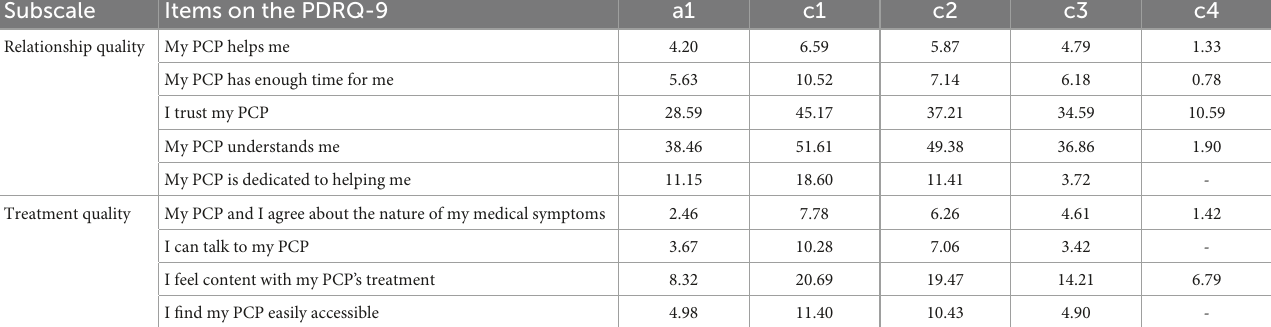
TABLE 5 Item content of patient-doctor-relationship questionnaire (PDRQ-9) subscales and item response theory (IRT) item parameter estimates.